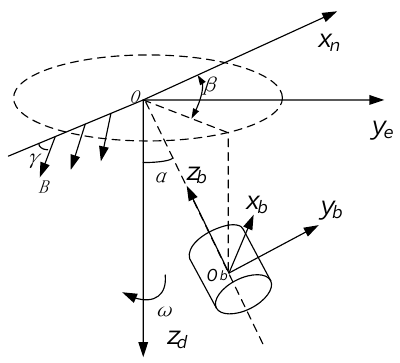
Figure 4. Attitude measurement based on the geomagnetic field.